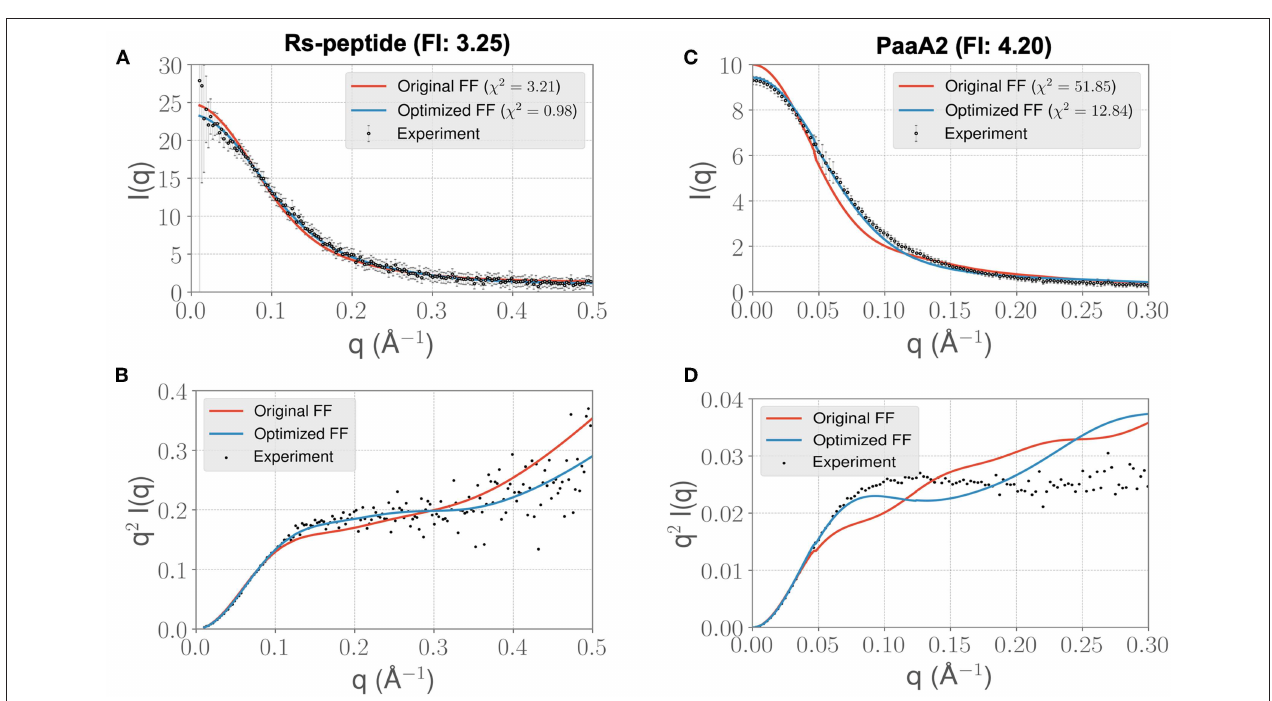
FIGURE 3 | ForceBalance-SAS based simulations generate IDP ensembles that are better fit to the experimental SAXS observables at shorter timescales. (A) The scattering profiles for RS-peptide showing the experimental data (black dots with error bars) along with the predicted SAXS scattering profiles from the original FF simulations (red lines) vs. the optimized FF simulations (blue lines). For clarity, the χ 2 values between the experiment and the respective simulations are shown in the legend. (B) The Kratky plot from experiments (black dots), and predicted profiles from simulations (red line corresponding to the original FF, blue line—optimized FF). For clarity, the error bars from the experiments are excluded. (C,D) Highlight the same comparison for the PaaA2 system. The factor improvement (FI) in the χ 2 values between the optimized and original FFs are listed above each protein system.